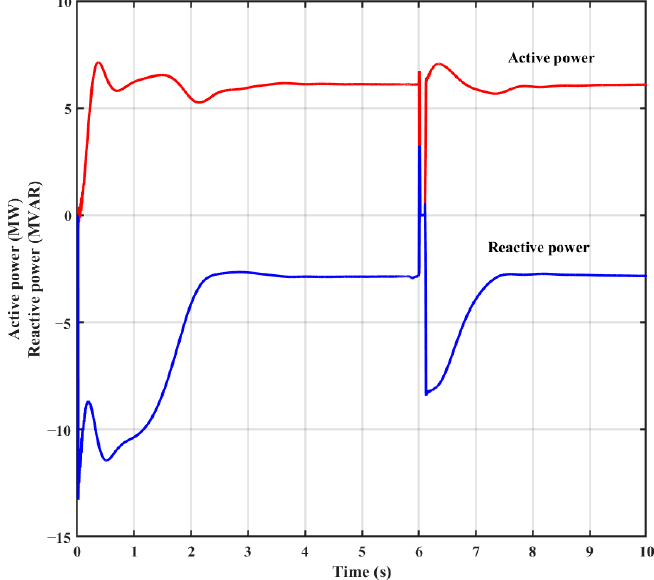
Figure 27. Active and reactive power supplied to PCC bus with LLLG fault.